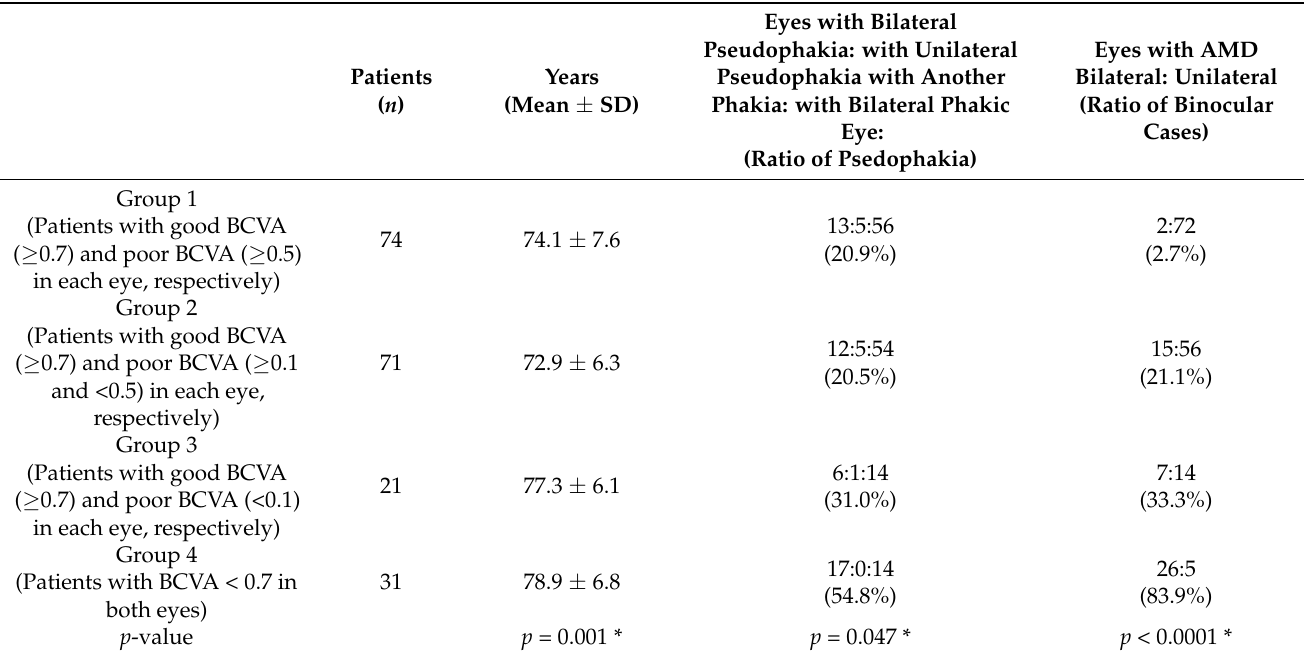
Table 2. Characteristics of each group.